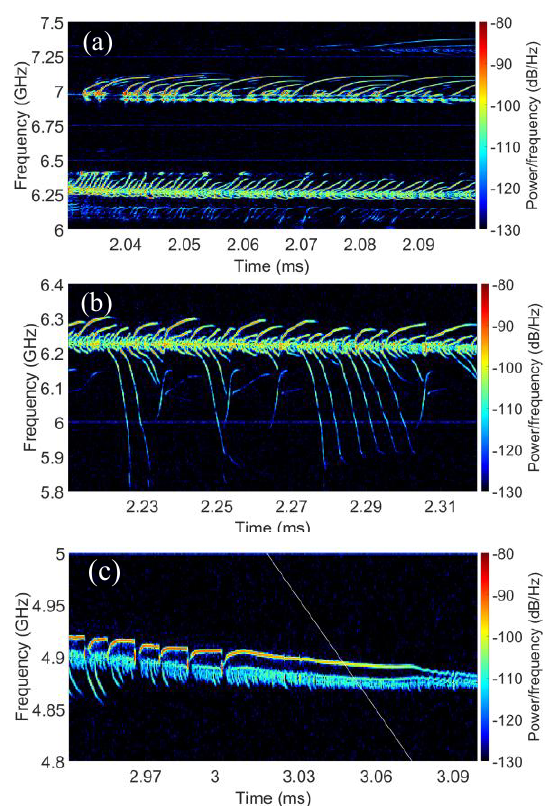
Fig. 2. Different regimes of chirping events in plasma emission spectrum observed during plasma decay. Panels ( a ) – ( c ) cor- respond to different sequential time slots. The white line shows the value of electron cyclotron frequency in the trap center on the axis. The ECR heating is operating during 0 – 1 ms (not shown)